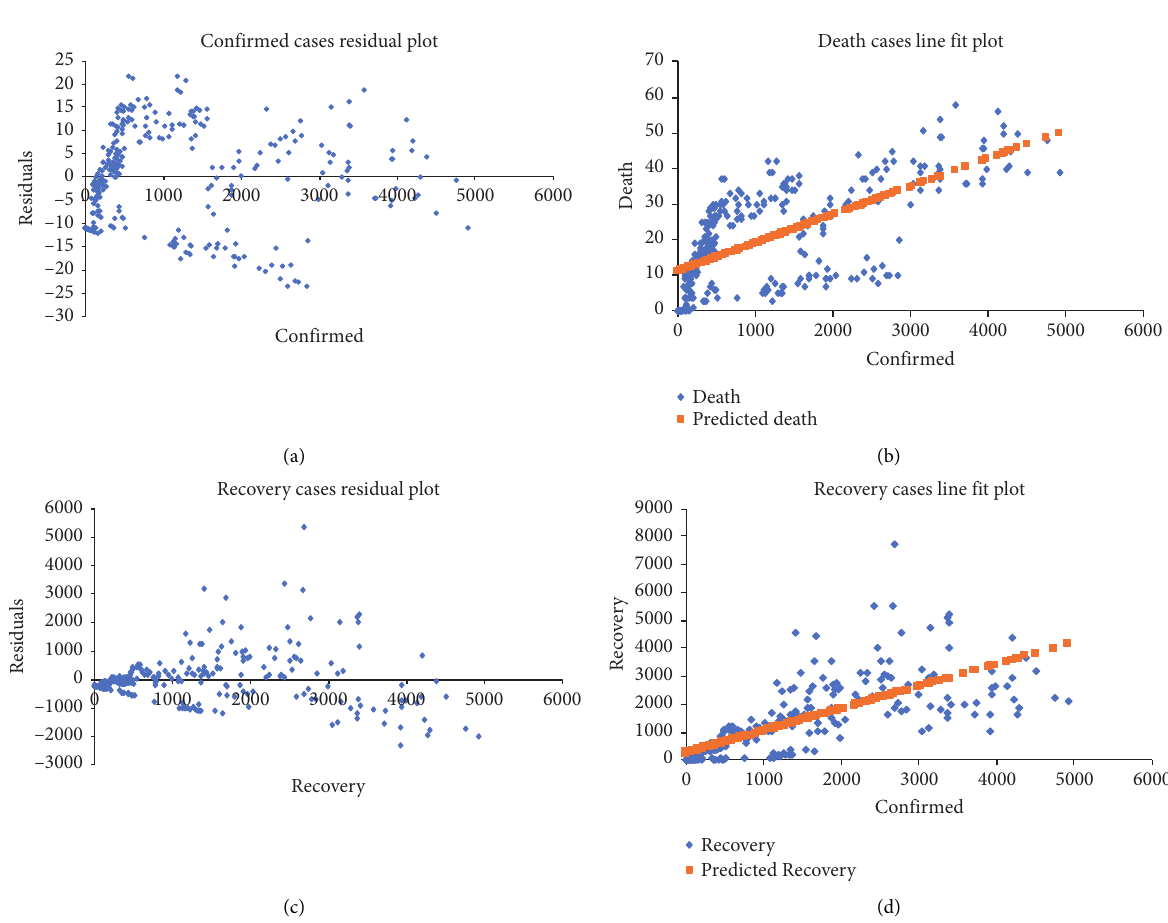
Figure 2: Statistical analysis showing (a) the residual plot for confirmed cases, (b) line fit plot for confirmed and death cases, (c) residual plot for recovery cases, and (d) line fit plot for confirmed and recovery